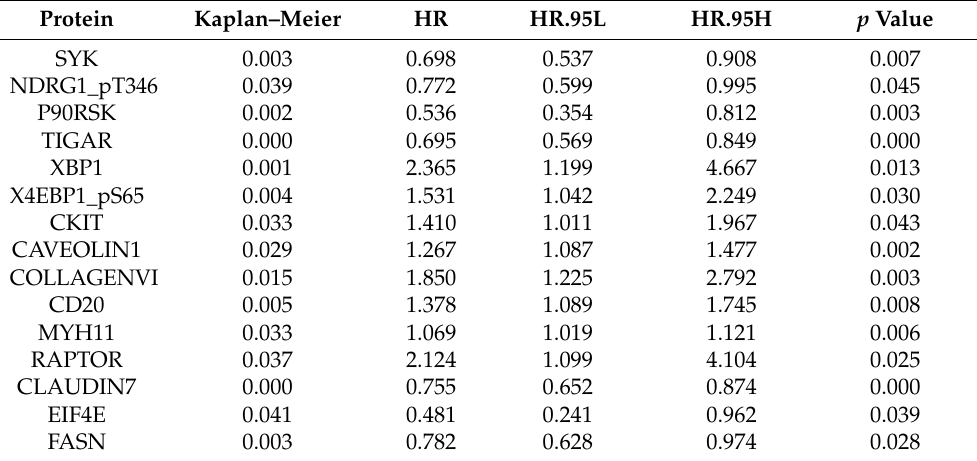
Table 1. Prognosis-related proteins identified using both Kaplan–Meier ( p value) survival analysis and univariate Cox